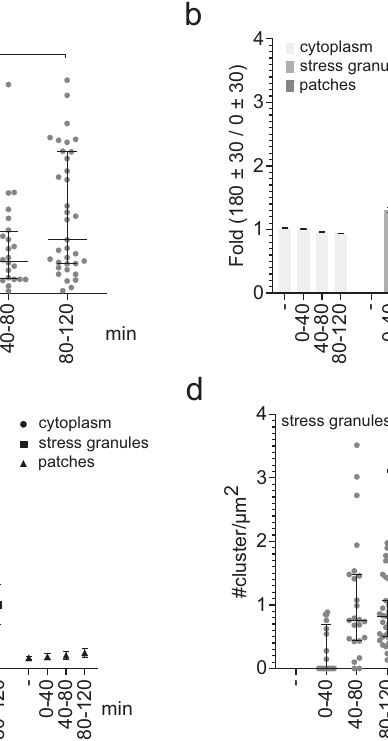
granules and in cytoplasmic patches at unstressed and different stress conditions. The data are presented as mean values +/ − STD and the standard deviations were calculated from the movie-wise distribution of diffusion coef fi cients. d Analysis of TDP-43 Halo localization cluster density inside of stress granules and the cytoplasm (stat. test: two-tailed Mann – Whitney, p -value=<0.0001). Data are displayed as the median +/ − the interquartile ranges). For all displayed data ( a – e ) the number of analyzed cells per condition ( n number) is given in Supplementary Table 1, the experiments cells were examined in independent experiments. Source data are provided as a Source Data fi